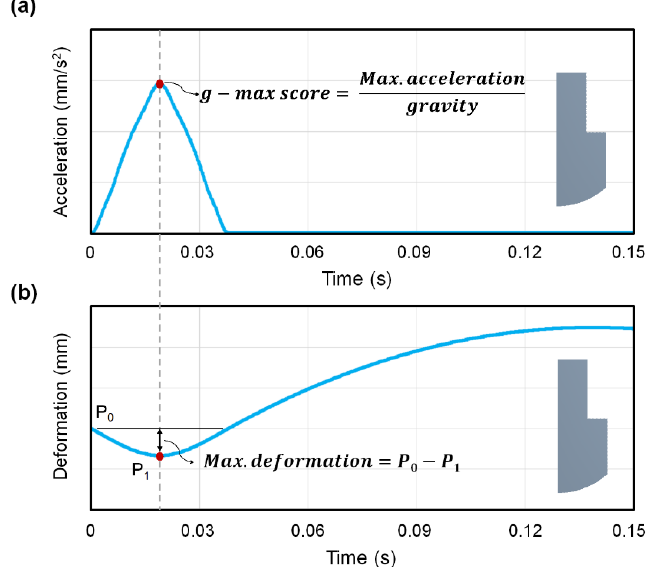
Figure 5. The definition of data output ( a ) g-max score, and ( b ) maximum deformation.